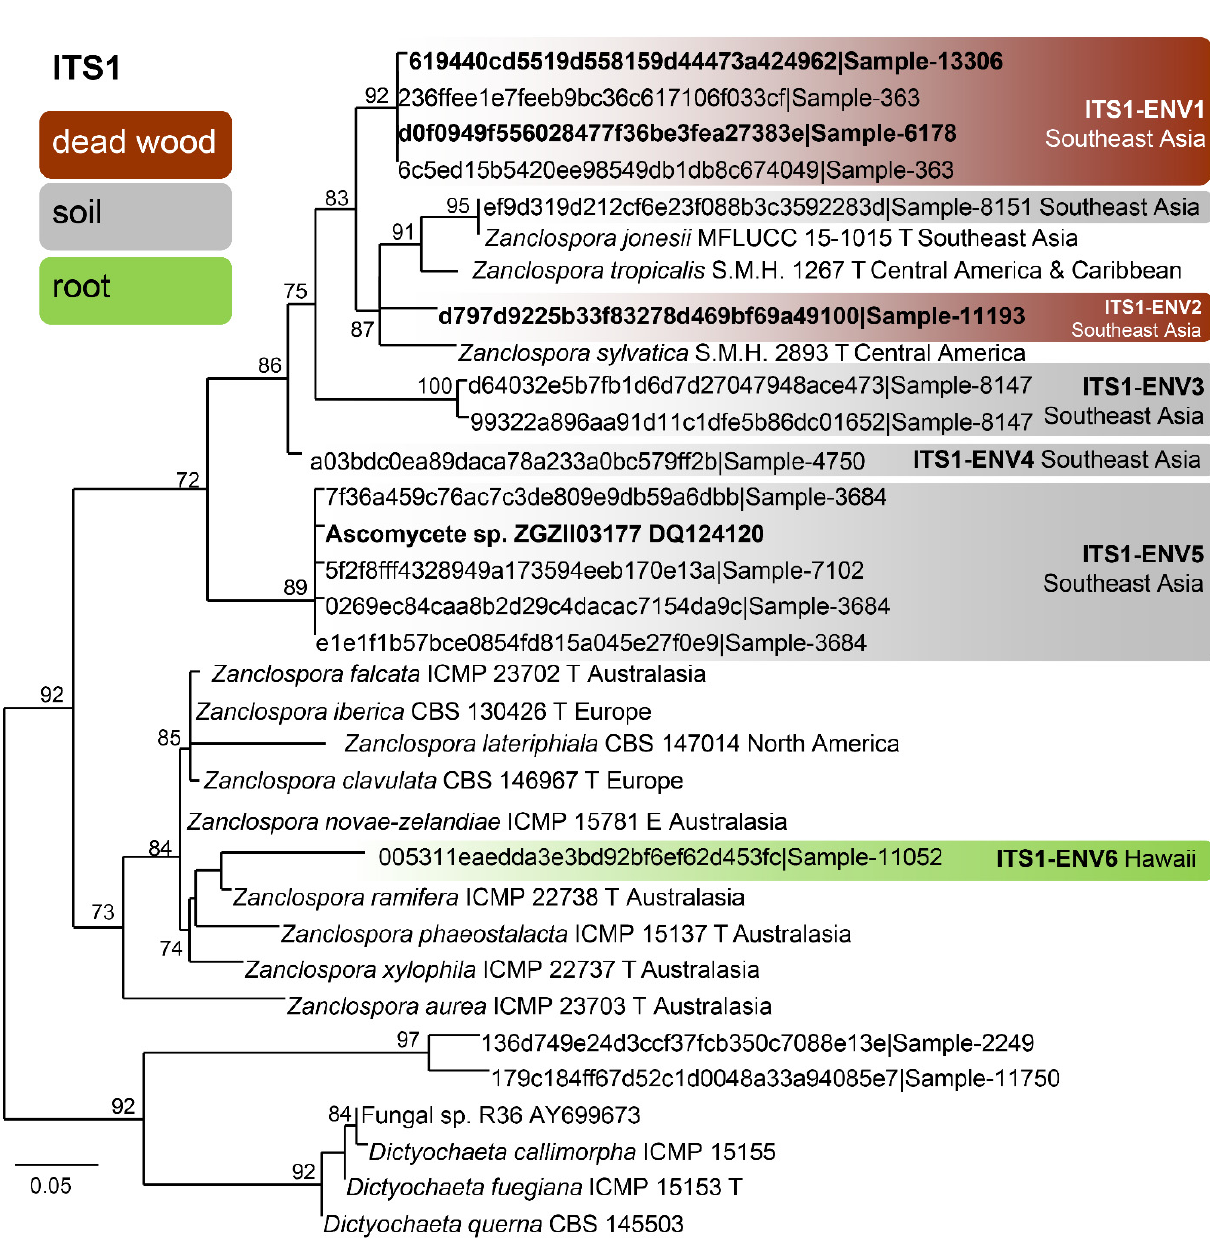
Figure 5. Phylogenetic relationships among Zanclospora species and related ITS1 environmental sequences deposited in the GlobalFungi database. The titles of sequences contain the sequence and sample codes taken from GlobalFungi. Branch support (ML) is retained at the nodes. Environmental samples in bold indicate those sequenced for the whole ITS region. Habitat of the environmental sequences is indicated by brown, grey and green boxes corresponding to dead wood, soil or roots.